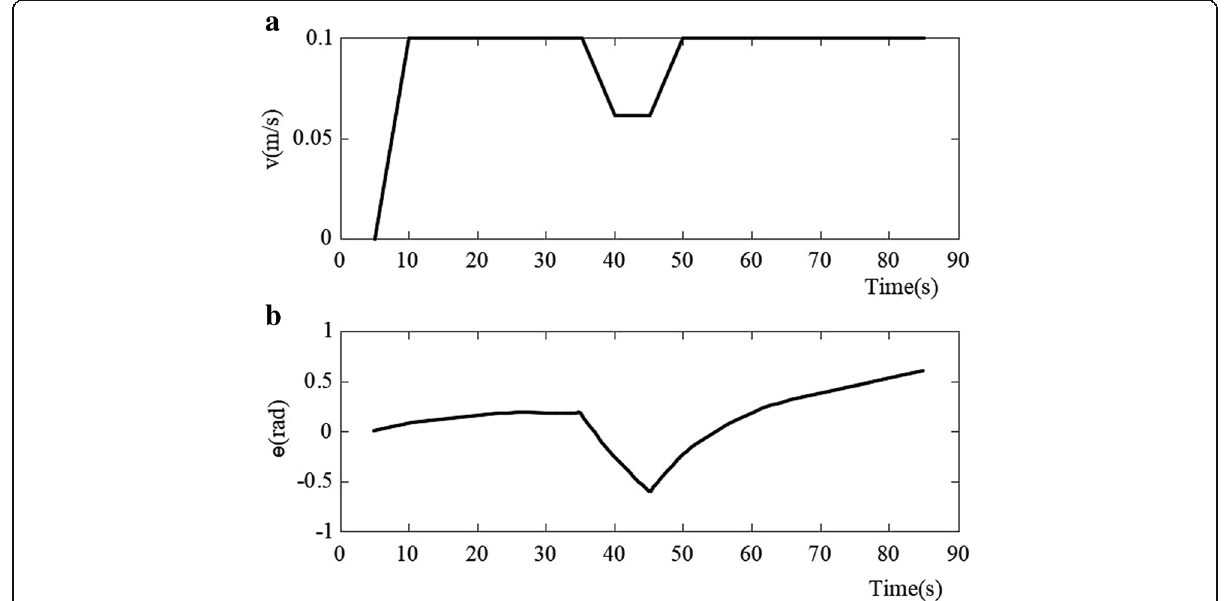
Fig. 7 a , b Curve of speed and attitude angle of